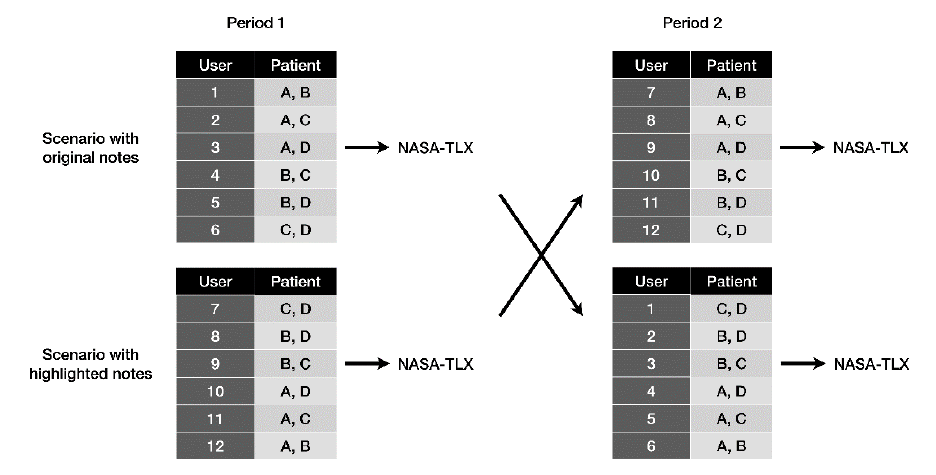
Figure 1. Workflow of the user experiment.